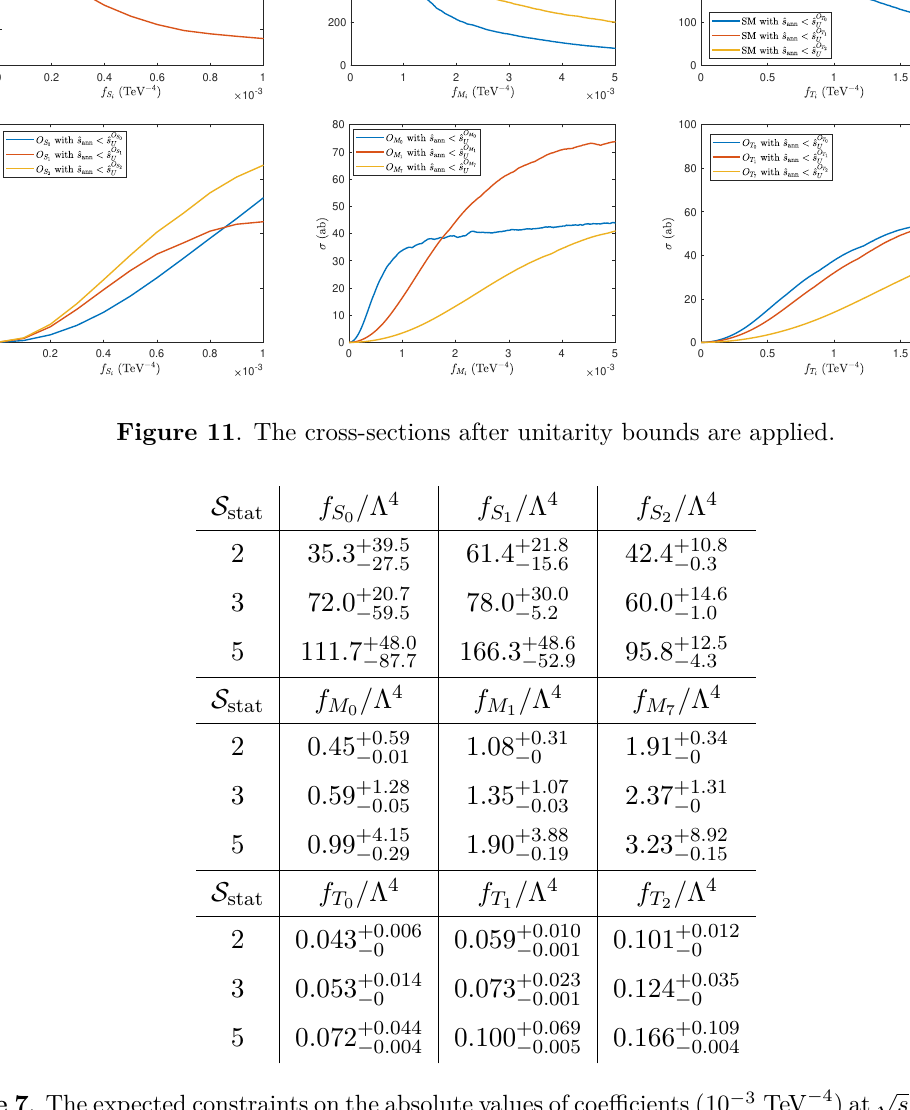
Table 7 . The expected constraints on the absolute values of coefficients ( 10 − 3 TeV − 4 ) at and L = 10 ab − 1 . The results by varying the unitarity bounds by factors 1 / 2 and 2 are presented as systematic